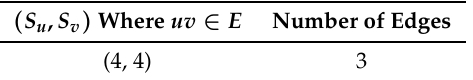
Table 7. Edge partition of G n ( n = 1 ) on the basis of degree sum of neighbors of end vertices of each edge.